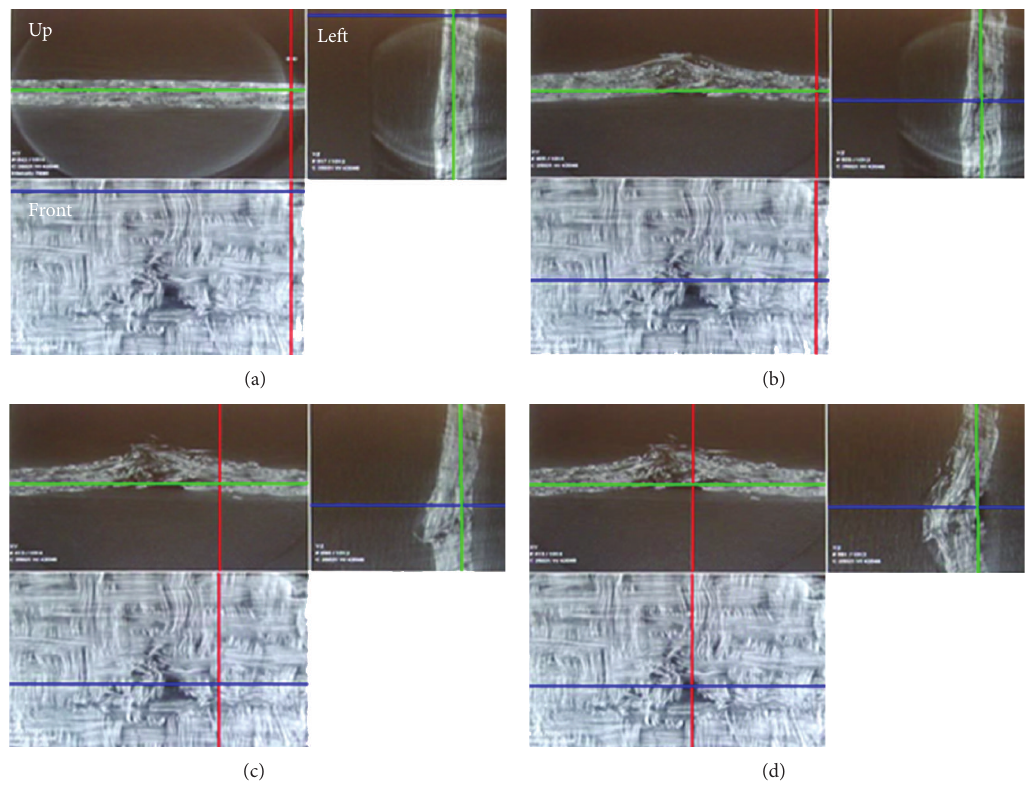
Figure 4: Example of the histogram of XMT analysis in an impacted laminate; the varying severity of fiber distortion, matrix cracking, and delamination can be noticed depending on the distance from the impact center.